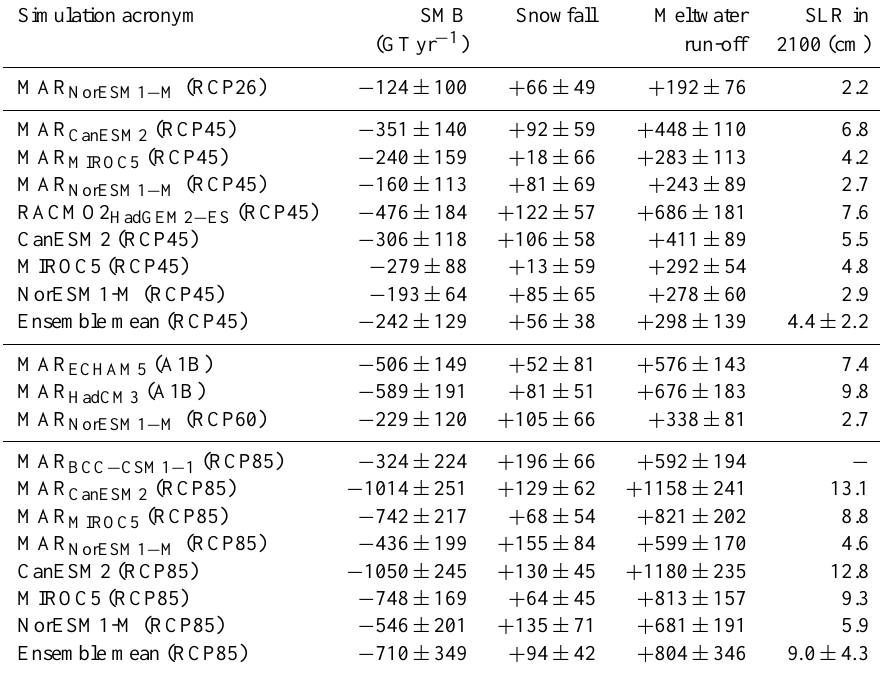
Table 3. Anomalies of SMB, snowfall, meltwater run-off (i.e. water run-off minus rainfall) in 2080–2099 with respect to 1980–1999 as well as the cumulated sea level rise in 2100 resulting from SMB anomalies over 2000–2100 simulated by the RCMs as well as by the CMIP5 GCMs using Eq. (1). SMB